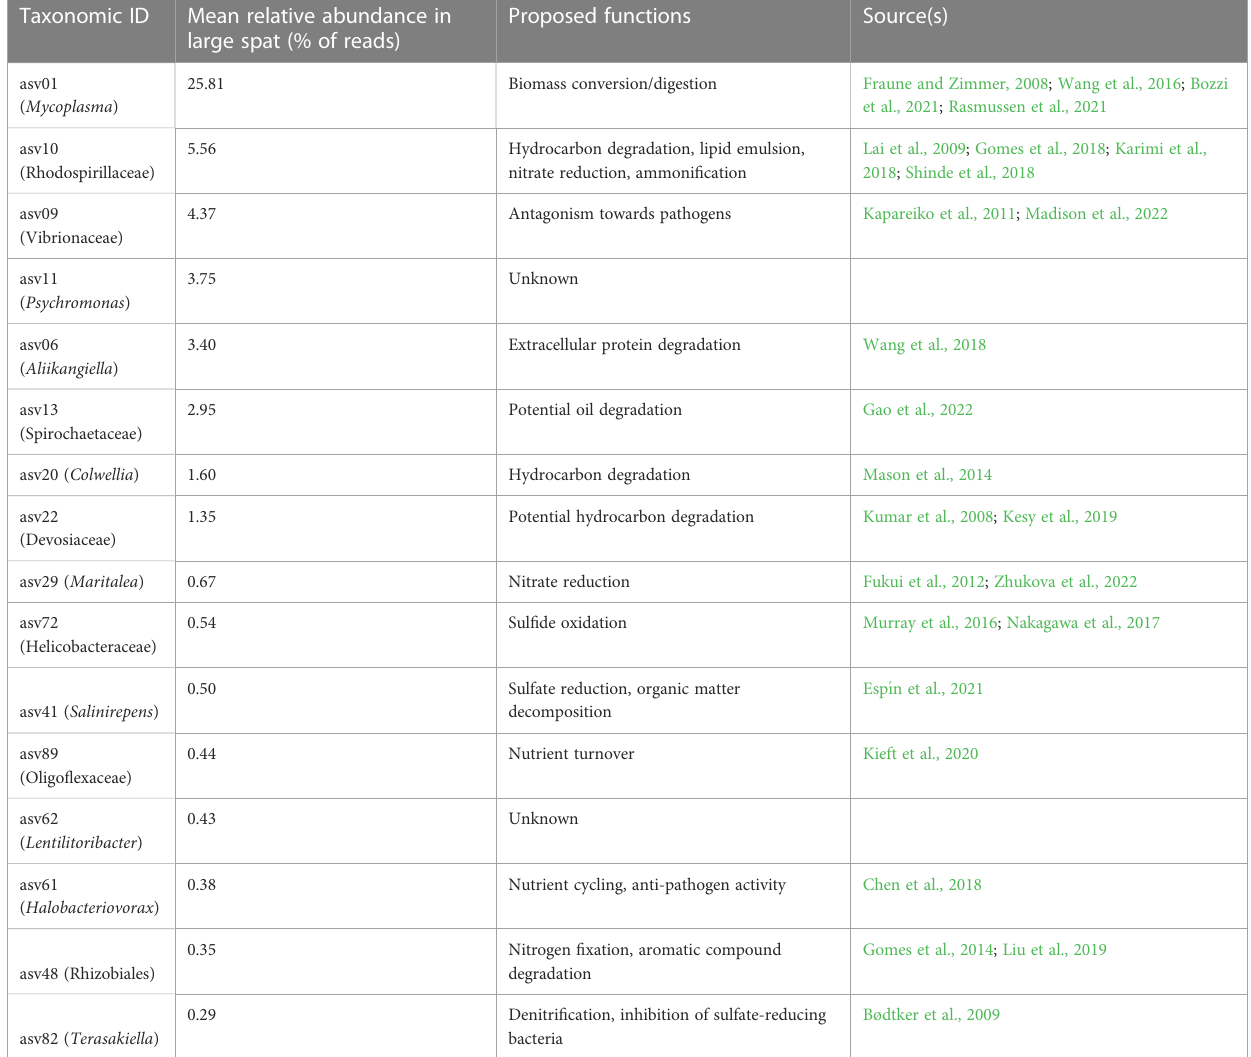
TABLE 1 Proposed functional roles of ASVs differentially abundant in large spat, sorted by relative